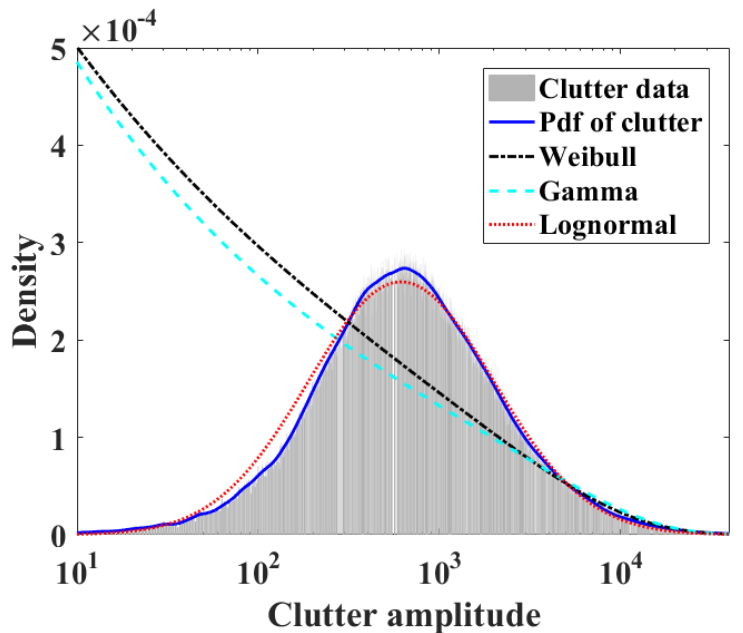
Figure 3. Probability density distribution of sea clutter in TF domain on 5 October 2015.